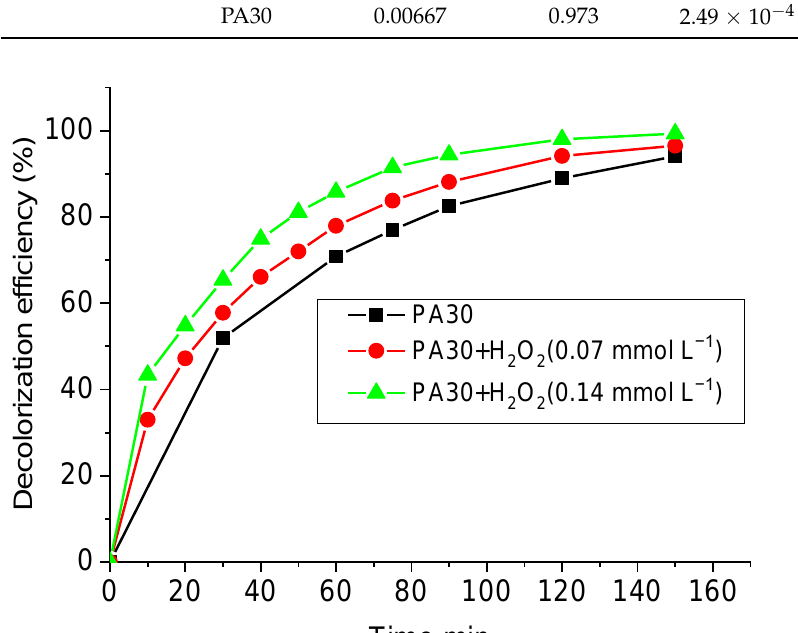
Table 6. Kinetic parameters of the discoloration reaction run with adsorbent PA30 and the addition of H 2 O 2 .